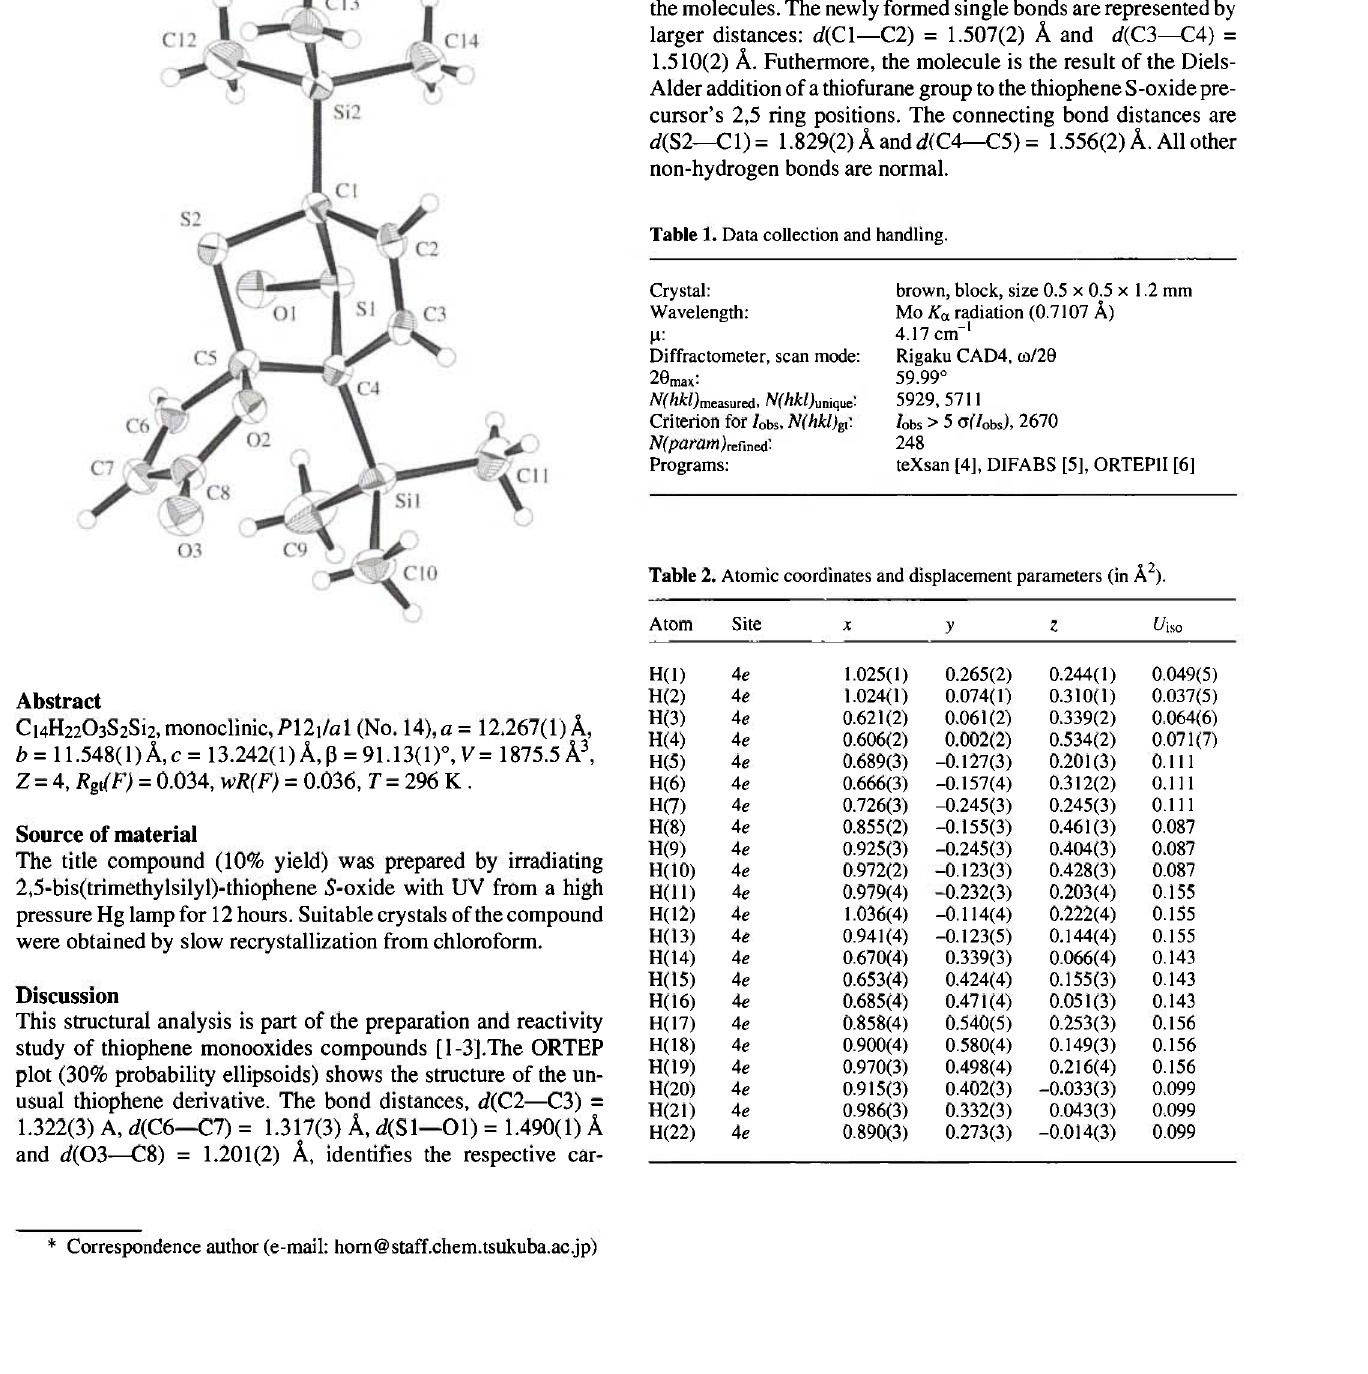
Table 1. Data collection and handling.